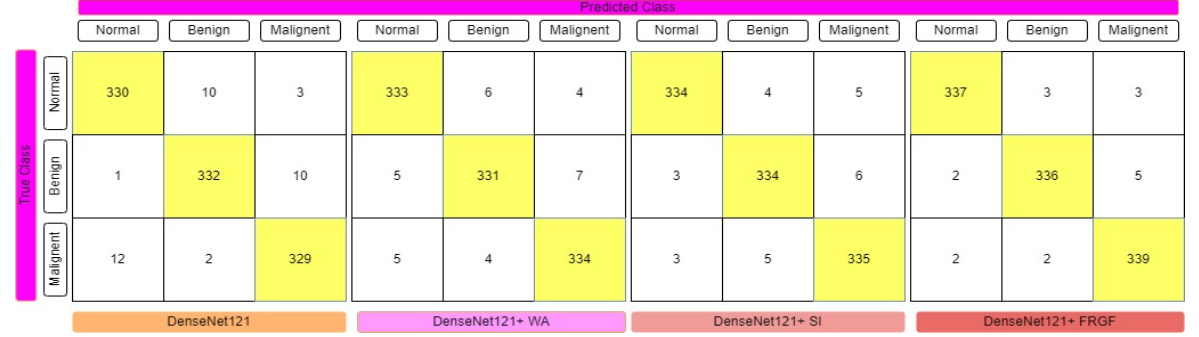
Figure 11. Confusion matrix representation of DenseNet121 deep CNN model with various fuzzy ensemble technologies. DenseNet121, DenseNet121+ WA, DenseNet121+ SI, and DenseNet121+ FRGF showed 96.31%, 96.99%, 97.47%, and 98.35% accuracy, respectively.